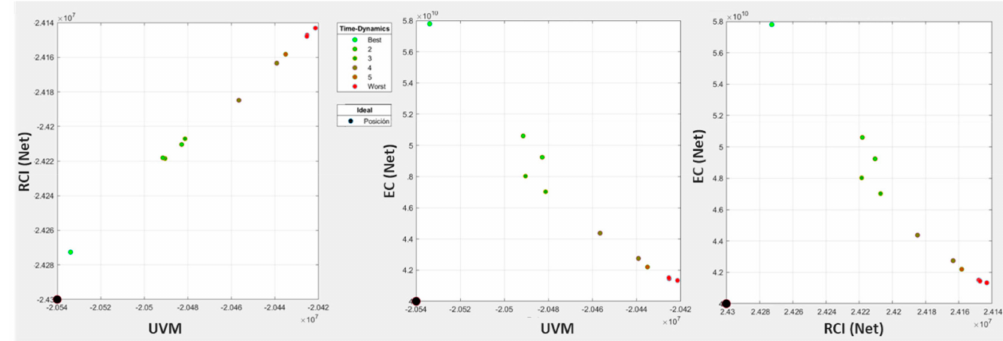
Figure 6. Trade-o ff s between